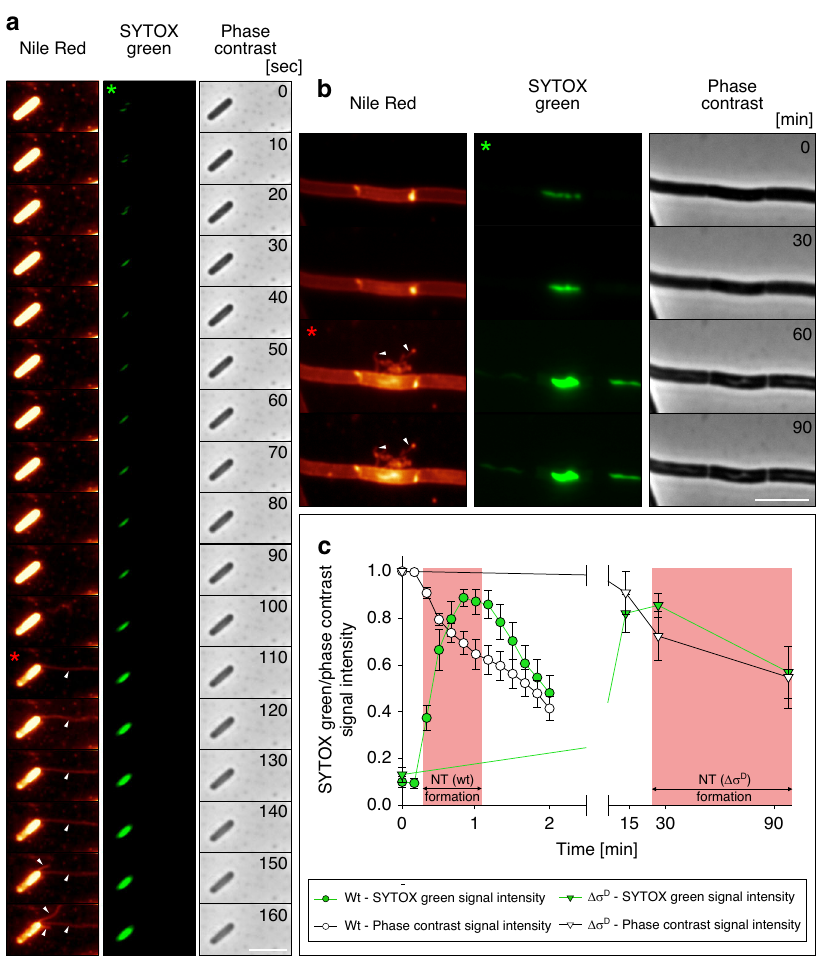
Fig. 3 Correlations between NT formation and cell death. a Exponentially growing wt B. subtilis (LK1432) cells stained with Nile Red (false colored glow) and SYTOX green (green). Bacteria were prepared by the P-GLG method. The cells were observed every 10 s. Three channels of the same cell are shown: Nile Red, SYTOX green, and phase-contrast. White arrows indicate NTs. The numbers in the phase-contrast panels are seconds. Notice the progressive loss of phase-contrast of the cells as the time advances. In panels a , b the green asterisk indicates the time when SYTOX green was inside the cell (i.e., the cell was dying). The red asterisk indicates the start of NT formation. b Δ sigD (LK1873) cells were prepared in the same manner as wt in a . White arrows indicate NTs. Numbers in the phase-contrast panels are minutes. Scale bar = 5 μ m. c Kinetics of NT formation and in wt (LK1432) and Δ sigD (LK1873) strains. NT formation occurs in dying cells of both strains, however, the kinetics of SYTOX green penetration and NT formation differs between these strains; it takes ~30x longer in Δ sigD . Symbol de fi nitions are shown below the graph. The pink area marks the time limits of NT formation for the two strains. The data represent three biological replicates (a total of 12 cells for wt and 11 cells for Δ sigD strain were analyzed)